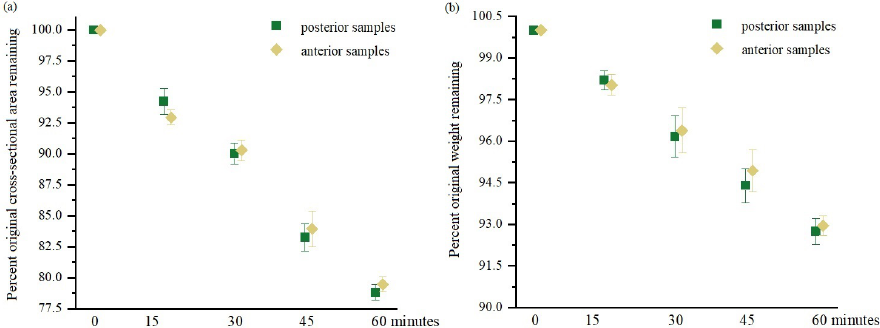
Figure 1. Change in cross-sectional area ( a ) and change in weight of fascicle bundles ( b ) during time (mean ± standard deviation). Values are given in percentage relative to the initial area measurement and weight immediately after excision (0 min); n = 10.